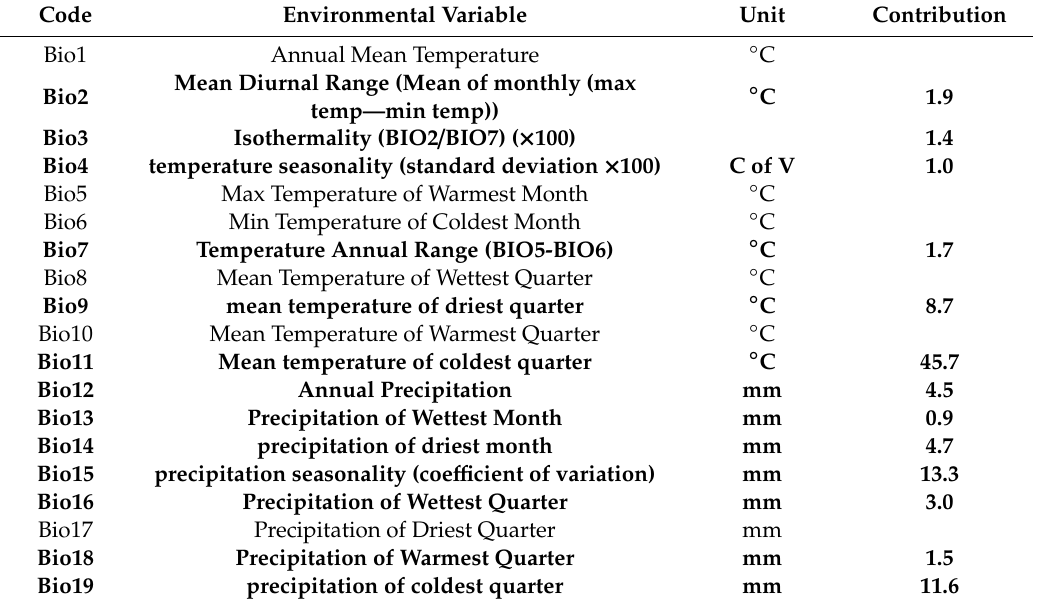
Table 1. Environmental variables and contribution